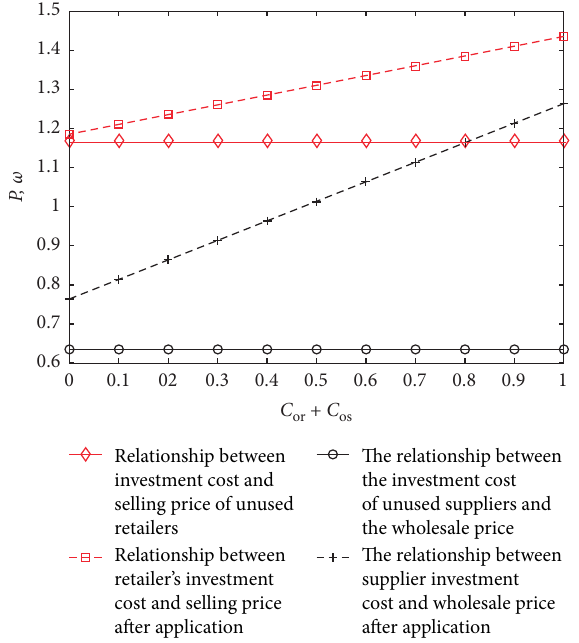
Figure 8: Retailer (e-commerce platform) and supplier investment BIP cost and price relationship